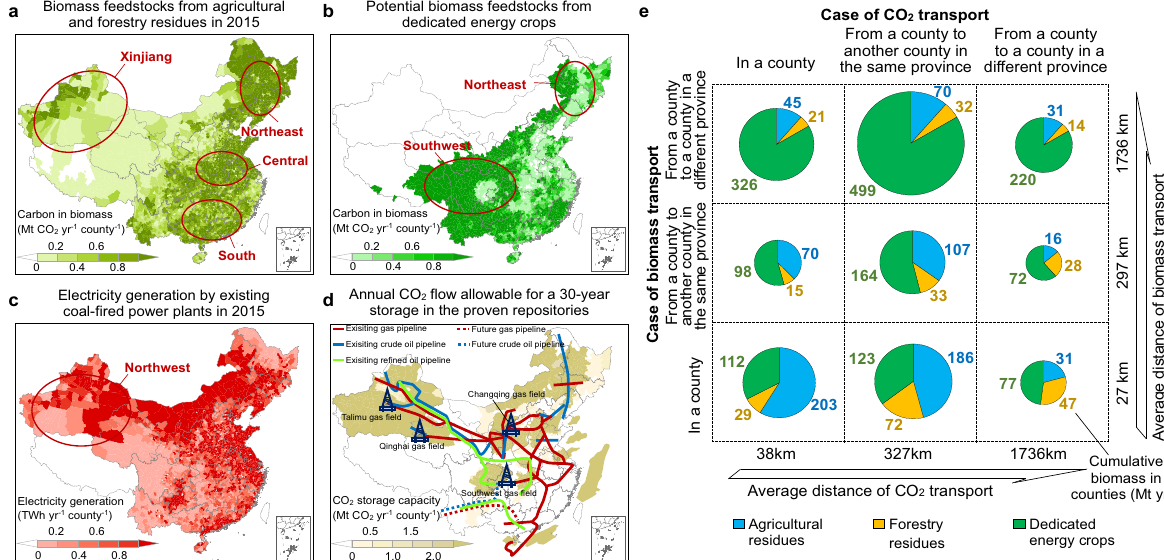
Fig. 2 Spatial distributions of biomass feedstocks, power plants, and capacity of carbon storage in China. a , b Feedstocks of ligno-cellulosic biomass from 11 types of agricultural residues and 8 types of forestry residues in 2015 and from dedicated energy crops grown on marginal lands and grasslands by county. c Electricity generation in coal- fi red power plants by county in 2015. d Capacity of CO 2 storage for 30 years in the proven land repositories and off- shore territories. The West-East pipelines constructed for natural gas are shown as lines. e Amounts of biomass burnt in power plants in each county based on three types of biomass transportation and three types of CO 2